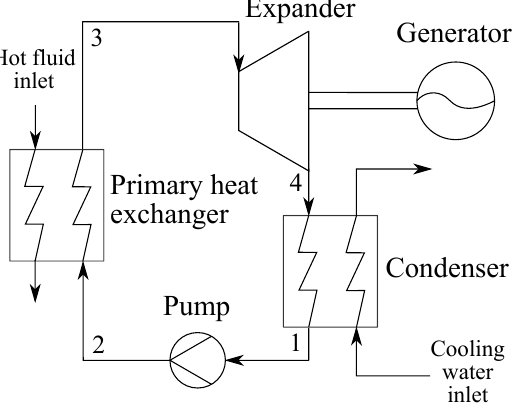
Figure 1. A sketch of the organic Rankine cycle